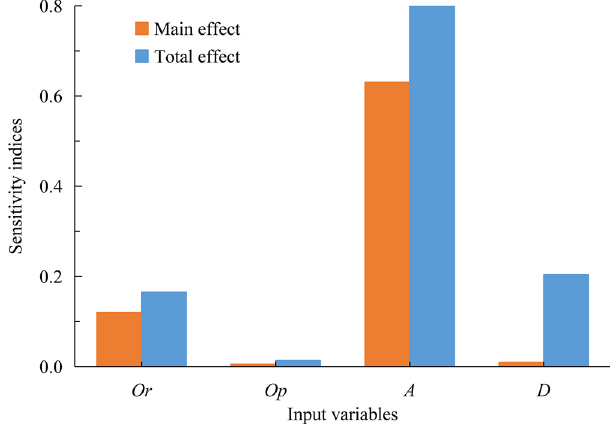
Figure 5. Main and total effects of parameters for debris flow peak impact